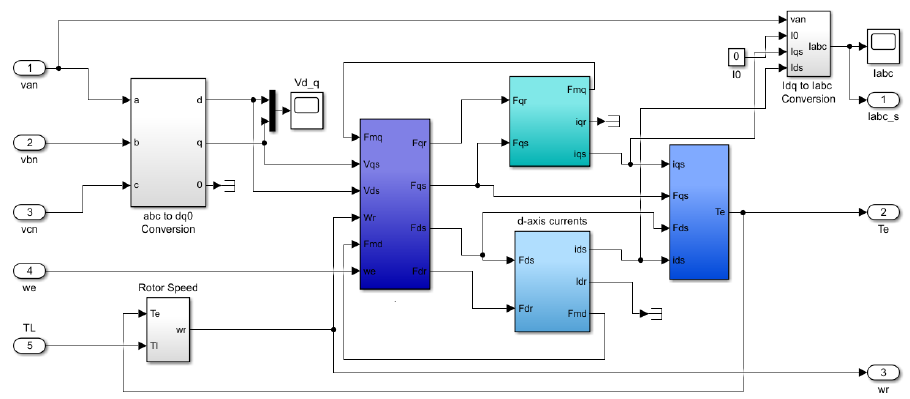
Figure 2. Simulation model of an IM with broken rotor